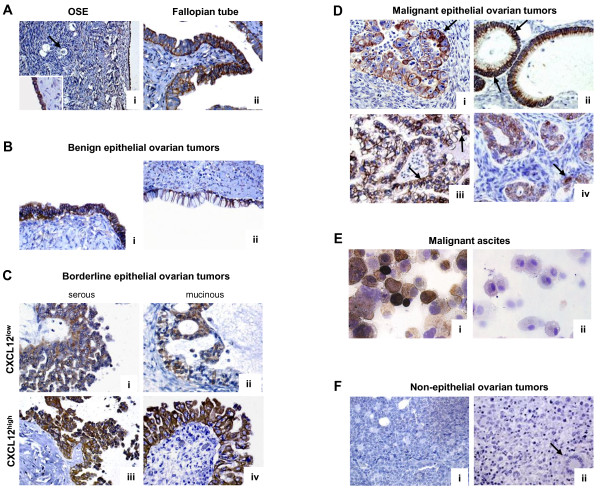
CXCL12 expression in healthy and malignant ovaries. (A) Healthy ovary (i), CXCL12 immunoreactivity in OSE (inset is the outlined region on the tissue specimen containing surface epithelium, × 40), faint staining in the stroma and no signal in follicles and oocytes (arrow) (× 20); fallopian tube (ii), CXCL12 immunoreactivity in cells of the epithelium (× 40). (B) Serous (i) and mucinous (ii) benign epithelial ovarian tumors, CXCL12 immunoreactivity in proliferating epithelial cells (× 40). (C) Serous (i and iii) and mucinous (ii and iv) borderline epithelial ovarian tumors with low (CXCL12low, i and ii) or high (CXCL12high, iii and iv) levels of CXCL12 staining (× 40). (D) Malignant epithelial ovarian tumors: serous (i), mucinous (ii), clear-cell (iii) and endometrioid (iv), CXCL12 immunoreactivity in epithelial cells is confined to the cytoplasm, with frequent strong staining of the membrane (arrows), no staining in the nuclei of tumor cells or in the stroma (× 40). (E) Cytocentrifuged CD326+ epithelial (i) and CD326- non epithelial (ii) cells isolated from malignant ascites collected from a patient diagnosed with invasive EOC, CXCL12 is detected only in CD326+ cells (× 40). (F) Non epithelial ovarian tumors: granulosa tumor (i) and dysgerminoma with characteristic morphological features, i.e. Exner bodies (arrow) (ii), absence of CXCL12 immunostaining from both tumors (× 40). No labeling was detected when the K15C anti-CXCL12 mAb was omitted or a 100-fold molar excess of recombinant CXCL12 was added to the mAb before incubation with tissues.